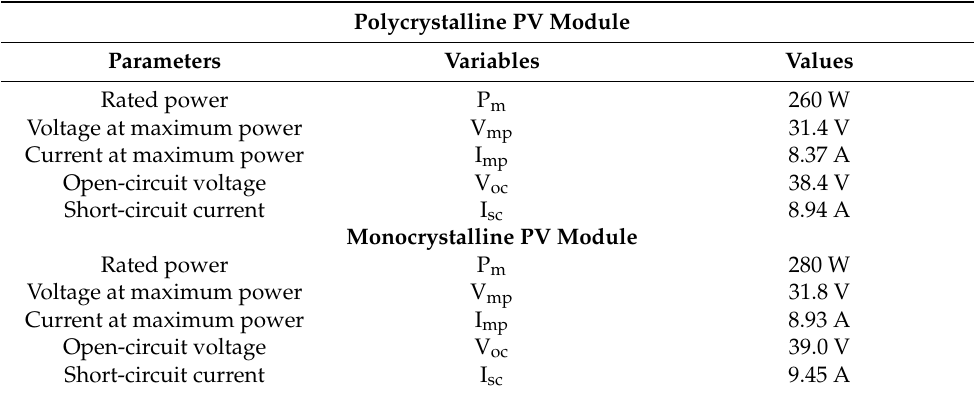
Table 1. Specifications of the polycrystalline and monocrystalline PV